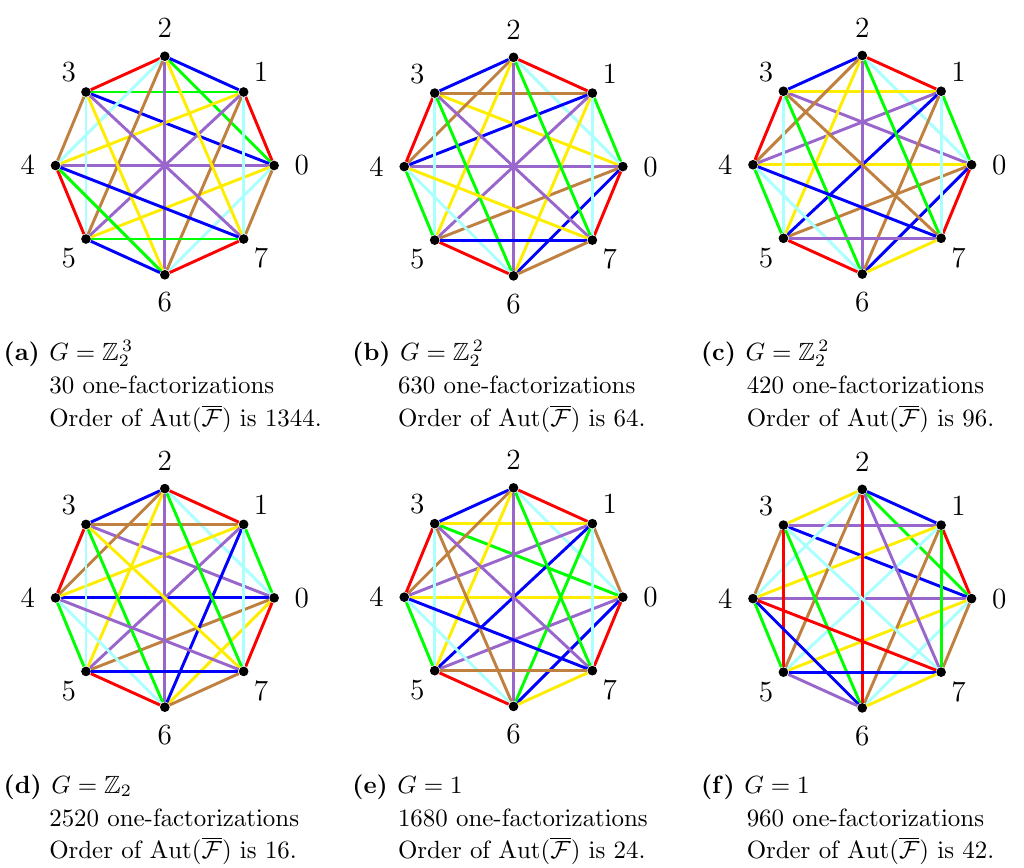
Figure 2. The six inequivalent melonic interactions and their symmetry factors for q = 8. Each interaction can be identi(cid:12)ed with an isomorphism class of one-factorizations, and we also list the number of one-factorizations in each class as well as j Aut( F ) j , the number of permutations in S 8 that preserve the one-factorizations in a given isomorphism class (see section 5 for an explanation of this notation). The canonical coloring is the bottom right.